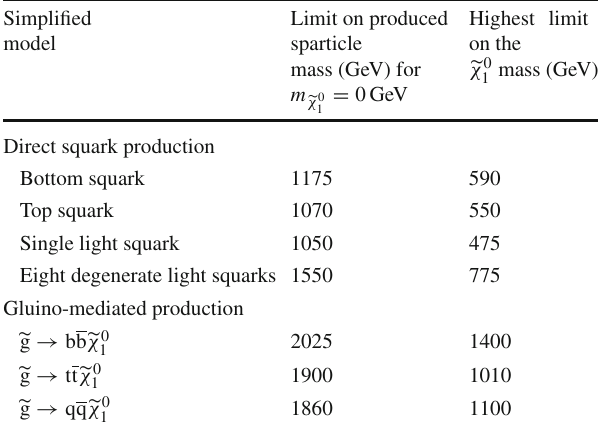
we quote the highest limit that is 1